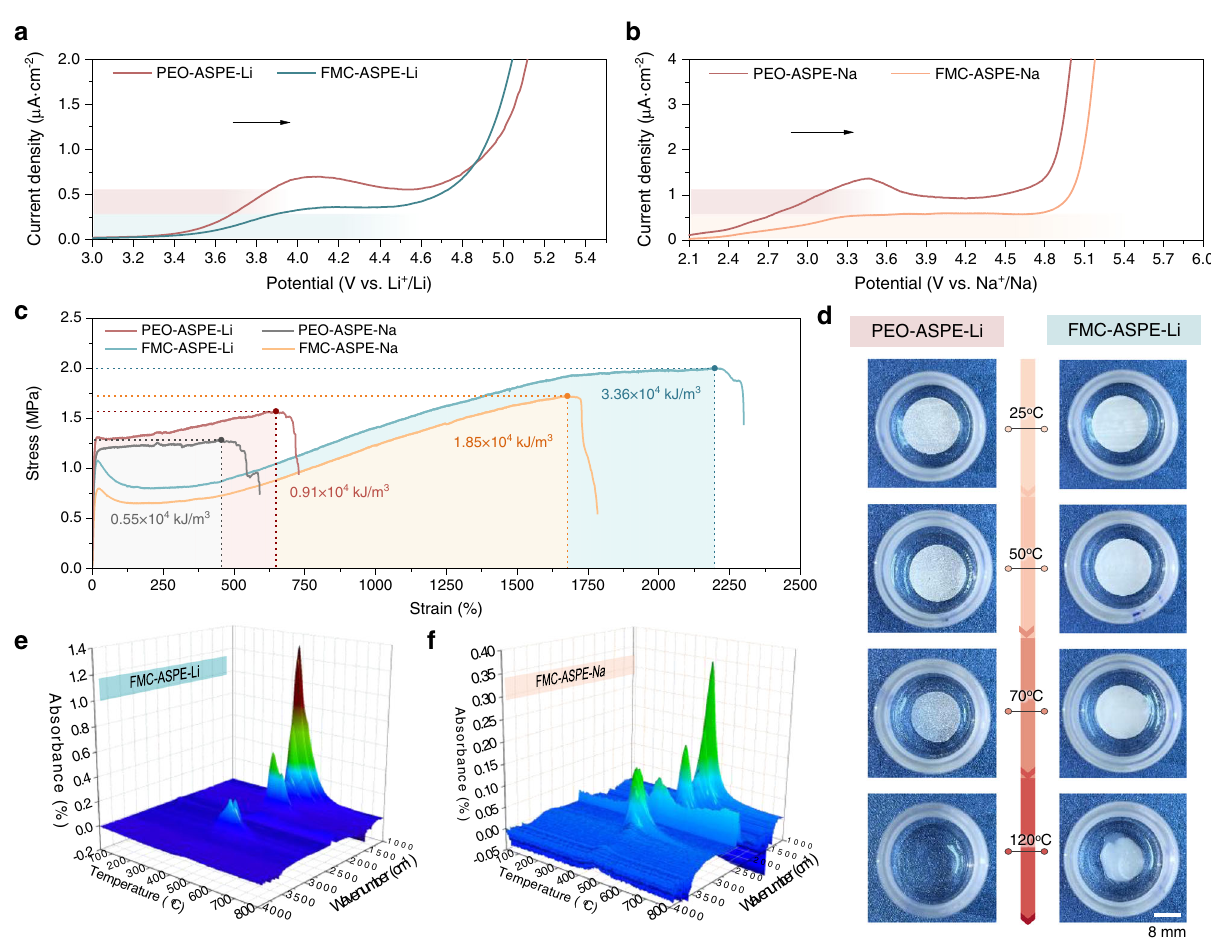
Fig. 2 Electrochemical and thermal stability tests of the fl uorine-rich macromolecule-containing and PEO-based polymer electrolytes. a , b Linear sweep voltammetry (LSV) test results for a FMC-ASPE-Li vs. PEO-ASPE-Li and b FMC-ASPE-Na vs. PEO-ASPE-Na. c The extension comparison of the four membranes. d Optical photographs of PEO-ASPE-Li and FMC-ASPE-Li heated to different temperatures. e , f Thermogravimetry-Fourier transform infrared spectroscopy (TG-FTIR) results for e FMC-ASPE-Li and f FMC-ASPE-Na.